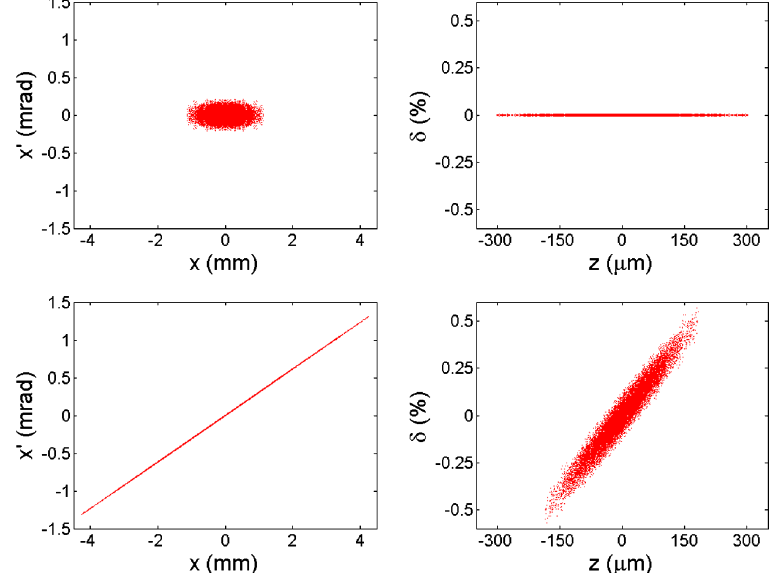
FIG. 4. Transverse phase space distribution (left plots) and longitudinal phase space distribution (right plots) before (top row) and after (bottom row) the chicane-type EEX beam